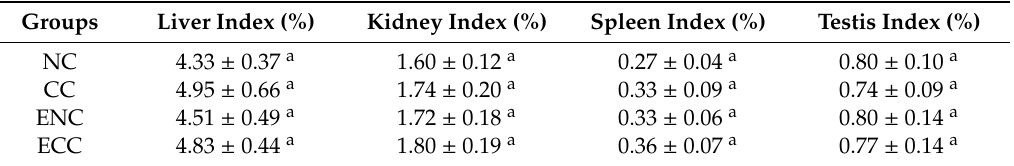
Table 7. Organ indexes of ICR